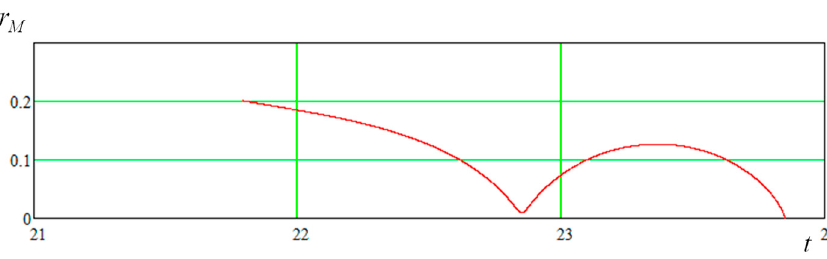
Figure 30. Section of the spacecraft’s selenocentric motion ending with the moment of entering the terminal orbit. The blue cross shows the point of application of the braking impulse. A fragment of the trajectory is shown in the selenocentric coordinate system with fixed axes oriented along the axes of the system ξСη ( ζ ) ( ξ M Сη M ( ζ )). The optimal two-impulse low-energy spacecraft flight trajectory obtained by solving problem (25) is shown in Figure 27. It is clearly seen that the resulting trajectory of prob- lem (25) with a functional expressing the total characteristic velocity of a two-impulse flight almost exactly coincides with the trajectories obtained by solving problems (21) and (23) with a functional (19). This is also confirmed by a direct comparison of the corre- sponding values of the vector of unknown parameters y for the three considered prob- lems. In general, this indicates the correctness of the approach, in which the perigee radius of the transfer orbit was chosen as the criterion for the optimality of the auxiliary problem; it also once again emphasizes the role of the Sun, because the considered formulations of the trajectory problem are aimed at maximizing the effect of perturbations (mainly from the Sun). Finally, let us consider the solution of problem (29). The solution of (29) for a given value of the initial inclination i 0 = 51.8 0 (to the geoequator) was found: from the solution of the flat auxiliary problem, approximations to the parameters ( Δ V 0 , t 0 , t f ) and optimal configuration of celestial bodies (Earth—Sun—Moon) were obtained (corresponds to β 0 , α M0 ). Next, a numerical solution of the optimization problem was determined—for this, the nonlocal CMA-ES algorithm [12] was used, which is a variant of the evolutionary strat- egy with adaptation of the covariance matrix. The numerical integration of the equations of motion was carried out using the Dorman and Prince DOPRI853 algorithm [13]. Below the results of the obtained solution (Figure 31 and Table 1) are presented (briefly).